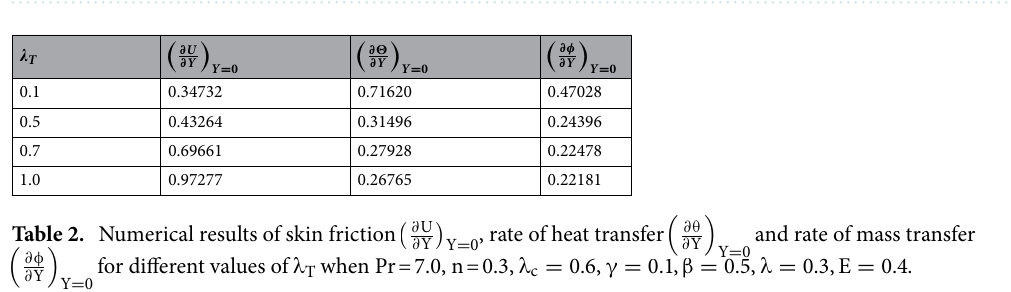
Figure 8. Dimensionless ( a ) Velocity U , ( b ) temperature θ and ( c ) mass distribution φ for different values of E = 0.01, 0.03, 0.05, 0.1 while n = 0.3 , γ = 0.1 , (cid:31) = 0.4 , β = 0.5 , (cid:31) T = 20.0 , (cid:31) c = 8.0 , Pr = 7.0, Sc = 0.2.